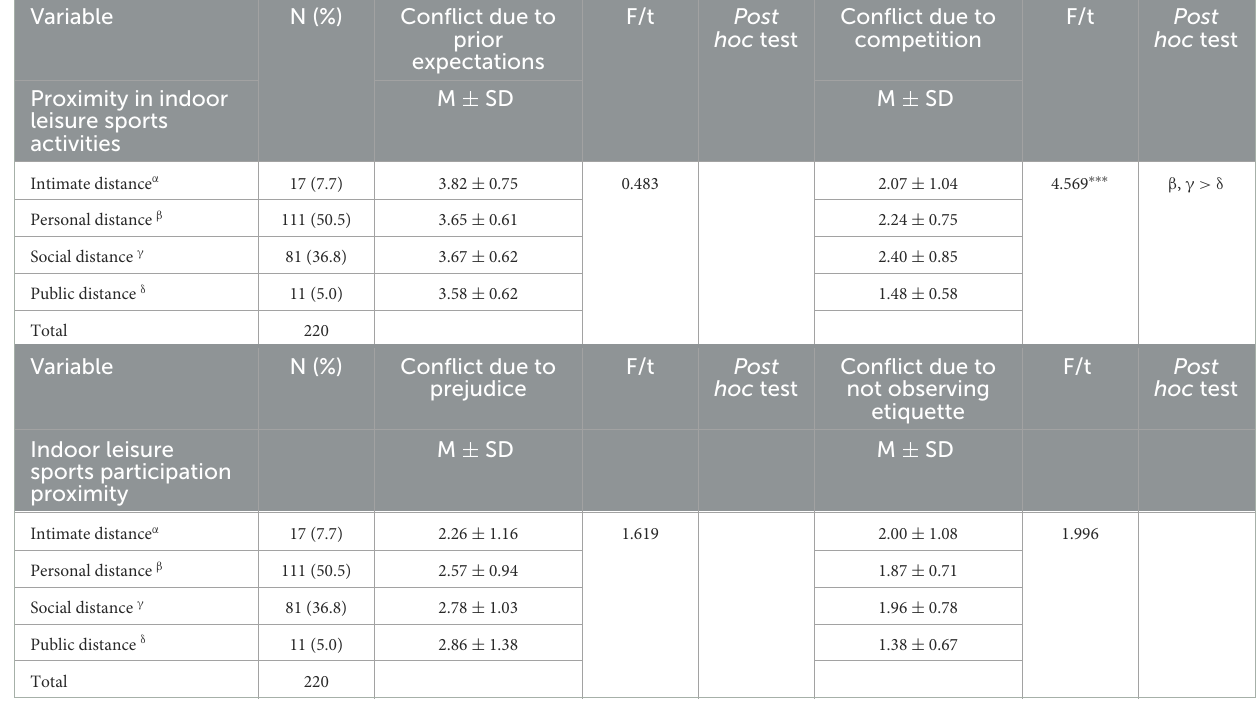
TABLE 3 Differences in leisure conflicts depending on spatial proximity among indoor leisure sports ( N = 220). Variable Conflict due to prior expectations